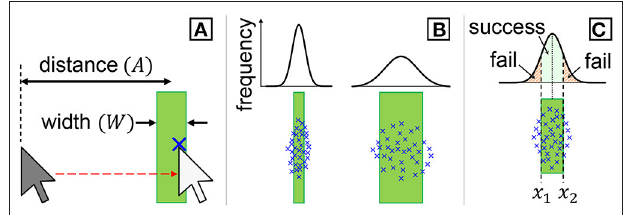
FIGURE 1 | (A) We use the Fitts’ law paradigm in which users point to a vertically long target. A clicked position is illustrated with an “x” mark. (B) It has been assumed that the click positions recorded in many trials distribute normally, and its variability would increase with the target width. (C) An error rate is computed based on the probability where a click falls outside the